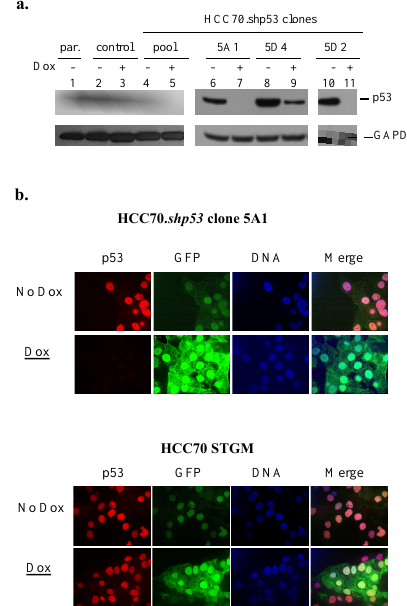
Figure 3. Inducible depletion of mtp53 proteins R248Q in breast cancer cell line HCC70. ( a ) The mtp53 expression in whole-cell extracts from parental HCC70 cell line (lane 1) and cell lines expressing vector control (control, lane 2,3) or mtp53-targeted shRNA (lanes 4–11), including HCC70. shp53 italic or not—Must be consistent pool (lane 4,5) and clonal cell lines (HCC70.shp53 5A1, lanes 6,7; HCC70.shp53 5D4, lanes 8,9 and HCC70. shp53 5D2, lanes 10,11) is shown. Cells were grown in the presence or absence of 8 µ g/mL doxycycline (Dox as indicated) for 6 days. Whole-cell lysates were prepared as described in the Materials and Methods section, and 50 µ g of protein was separated by gradient 4%–12% SDS/PAGE and analyzed by western blot using antibody to p53. GAPDH was used as a loading control. Expression of mtp53 in parental and control cell line are also shown (lanes 1 and 2 respectively); ( b ) confocal microscopy images of mtp53 protein were obtained by using anti-p53 antibody. DAPI staining was used to determine the nucleus, and GFP was an indicator of doxycycline-mediated induction. Nuclear immunofluorescence representing mtp53 in the HCC70.shp53 5A1 cell line reduced following doxycycline (top panel) and did not change in the control cell line (bottom